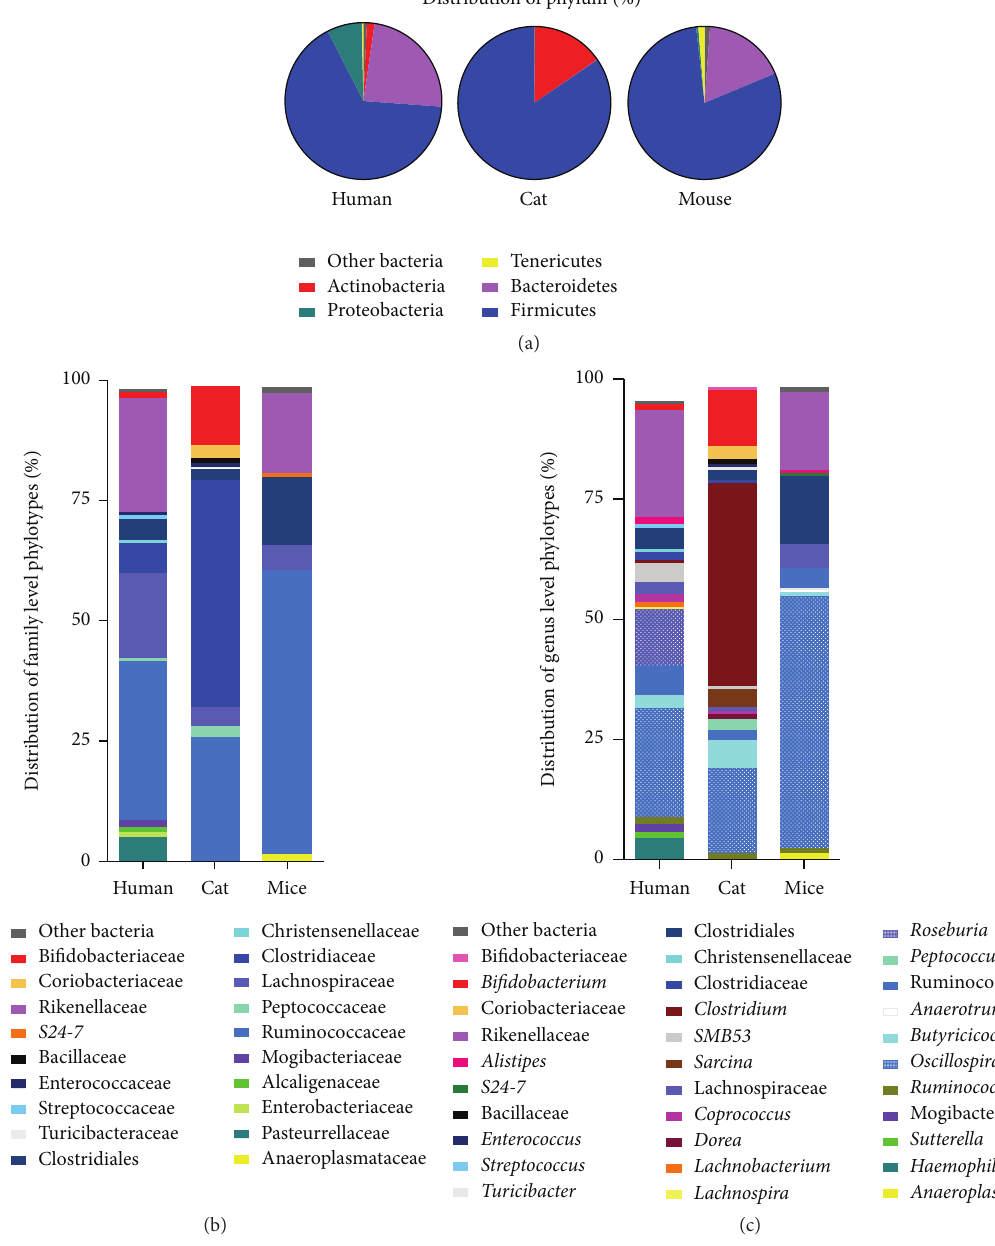
Figure 3: Bacterial community profiling of human, cat, and mouse fecal samples at the phylum (a), family (b), and genus (c) level phylotypes, illustrating possible simultaneous analysis of microbiota assessment of samples from distinct